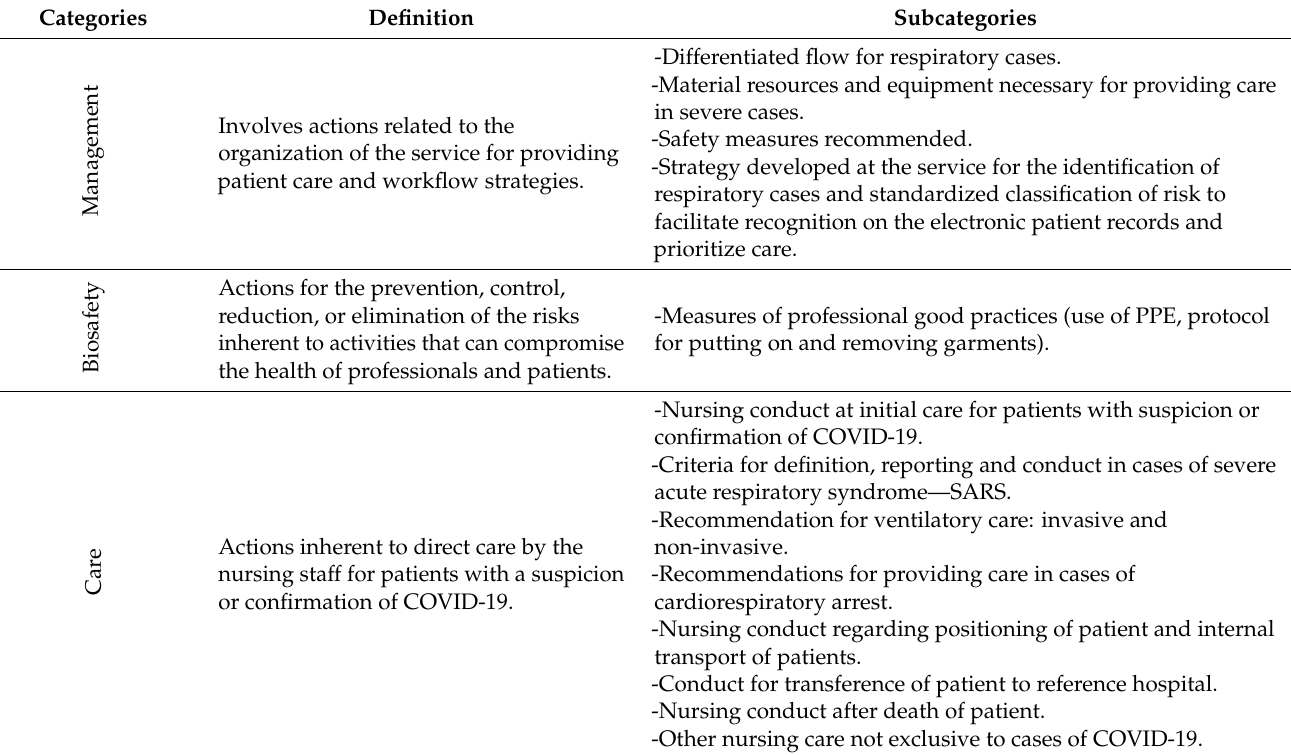
Table 1. Matrix of categories and subcategories identified in the